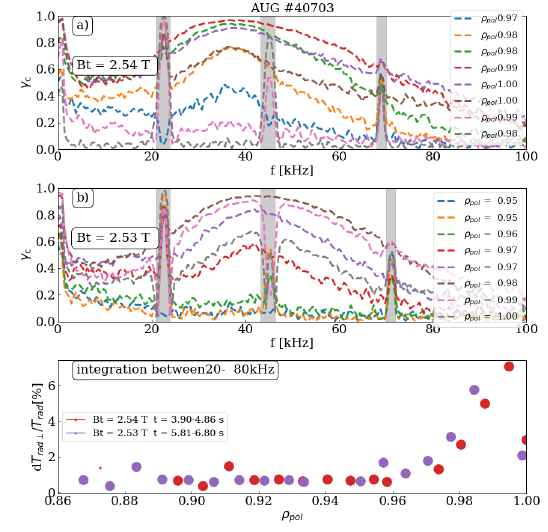
Figure 2. AUG #40703 a) Cross-coherence between subse- quent CECE channels for magnetic field strength of 2.54T. b) Cross-coherence between subsequent correlation ECE channels for magnetic field strength of 2.53T. c) Relative radiation tem- perature fluctuations integrated between 20 and 80kHz from the CECE measurements for B t = 2.54T in red and for B t = 2.53T in magenta, respectively. Grey regions are marking peaks of strong noise in the